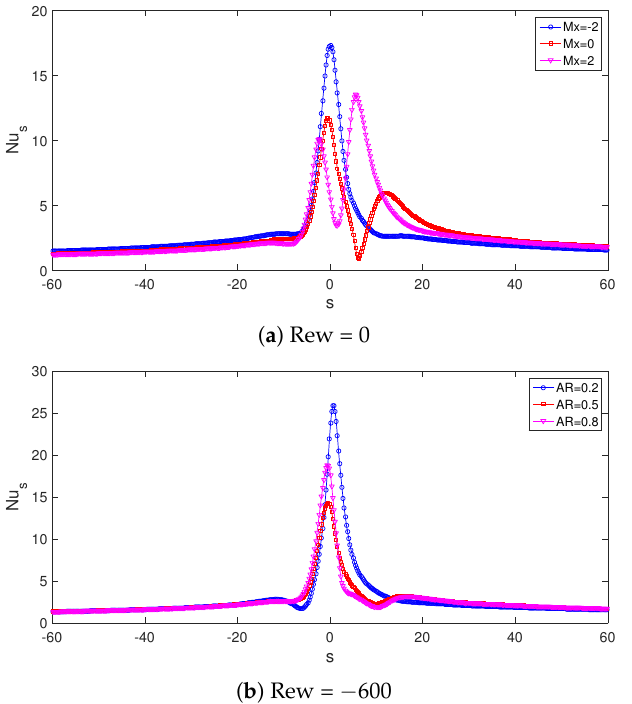
Figure 12. Local Nu distribution with varying ( a ) horizontal location and ( b ) aspect ratio of the porous object (Ha = 10,Da = 5 × 10 − 2